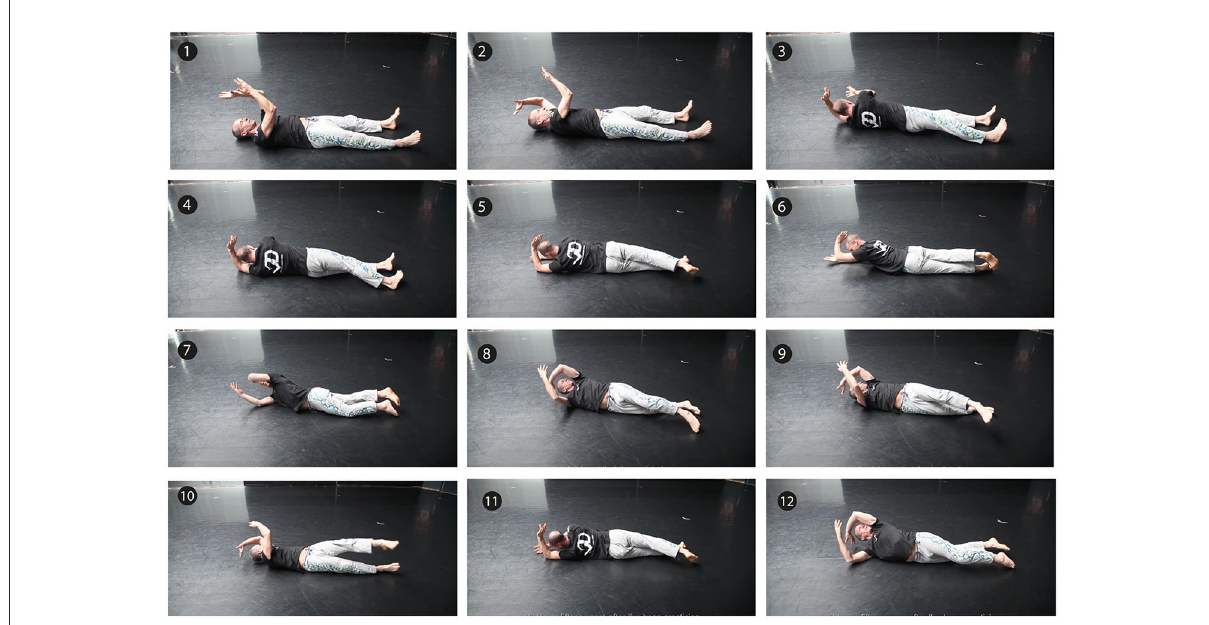
FIGURE6 Contact Improvisation: Sequence of working floor movement of spirals called “Helix roll” The Choreographer Mark Young in demonstration; Excerpts from the documentary film “Mark Young in Search of Spirality” (http://www.flamencoinvestigacion.es/mark-young/).